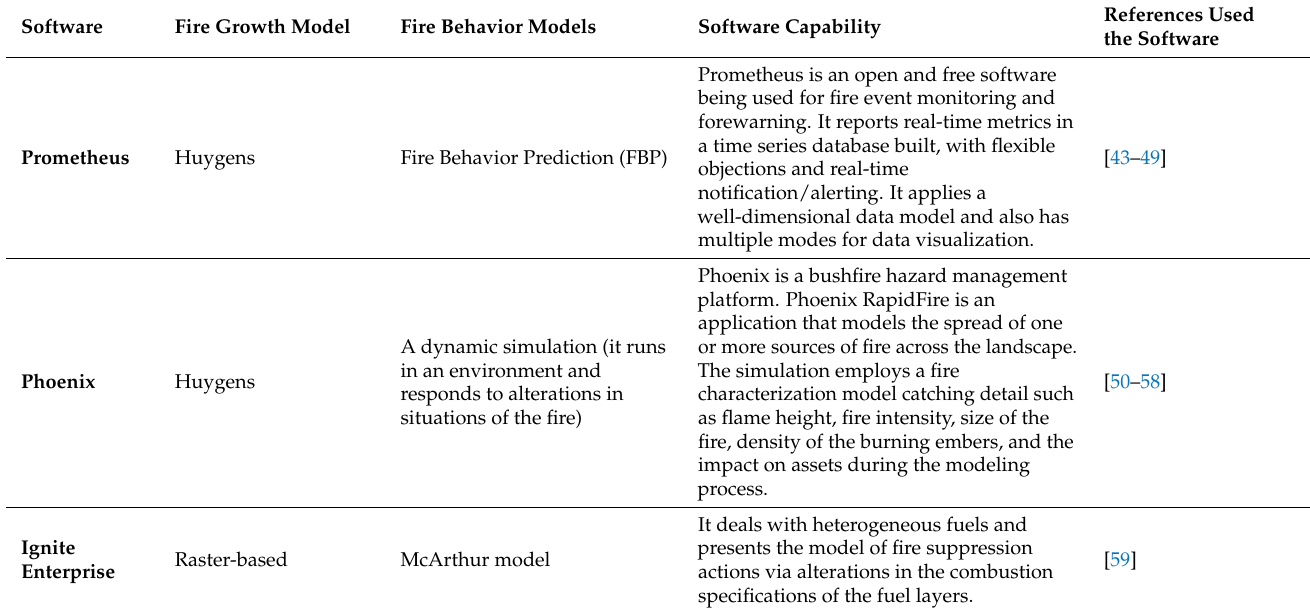
Table 1. Available computer software for fire